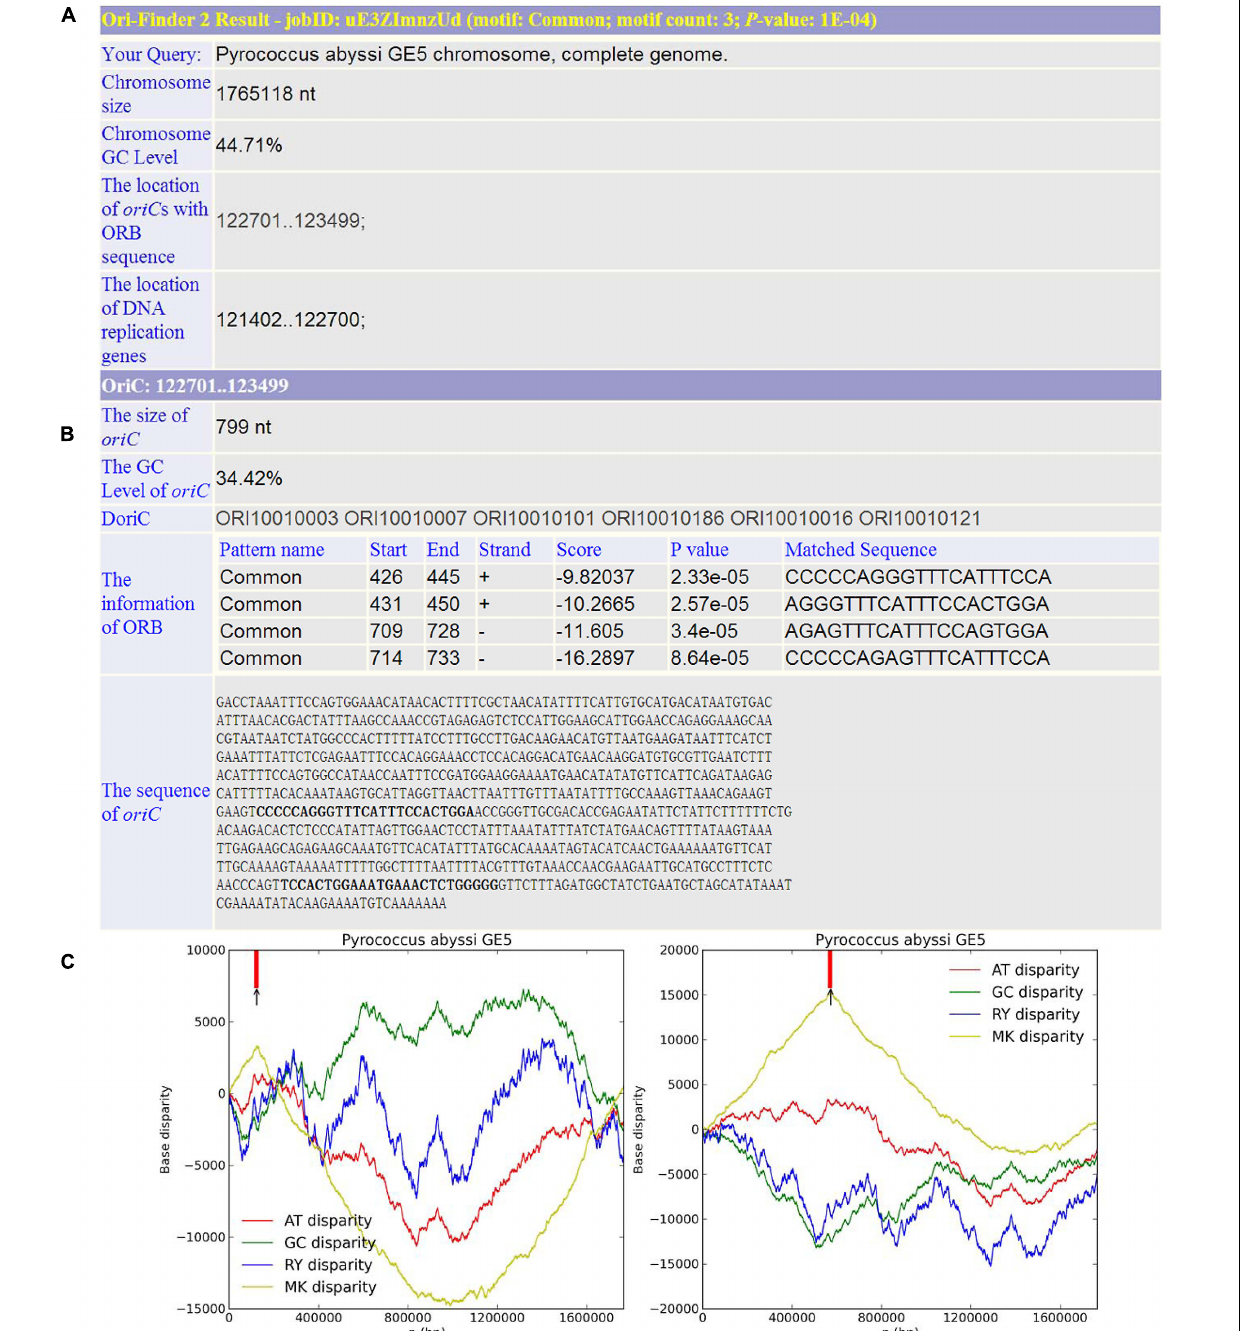
FIGURE 2 | Example of Ori-Finder 2 result for Pyrococcus abyssi GE5. (A) The information of genome size, GC content, the locations of replication-related genes and the predicted oriC s. (B) The detailed information of the predicted oriC region including size, GC content, homologs in DoriC and sequence, as well as the information of the identified ORBs including the ORB motif (also referred to as “Pattern name”), location, strand, the associated log-likelihood ratio score, P value and the matched sequences. Note that the log-likelihood ratio score and P value are computed by FIMO to